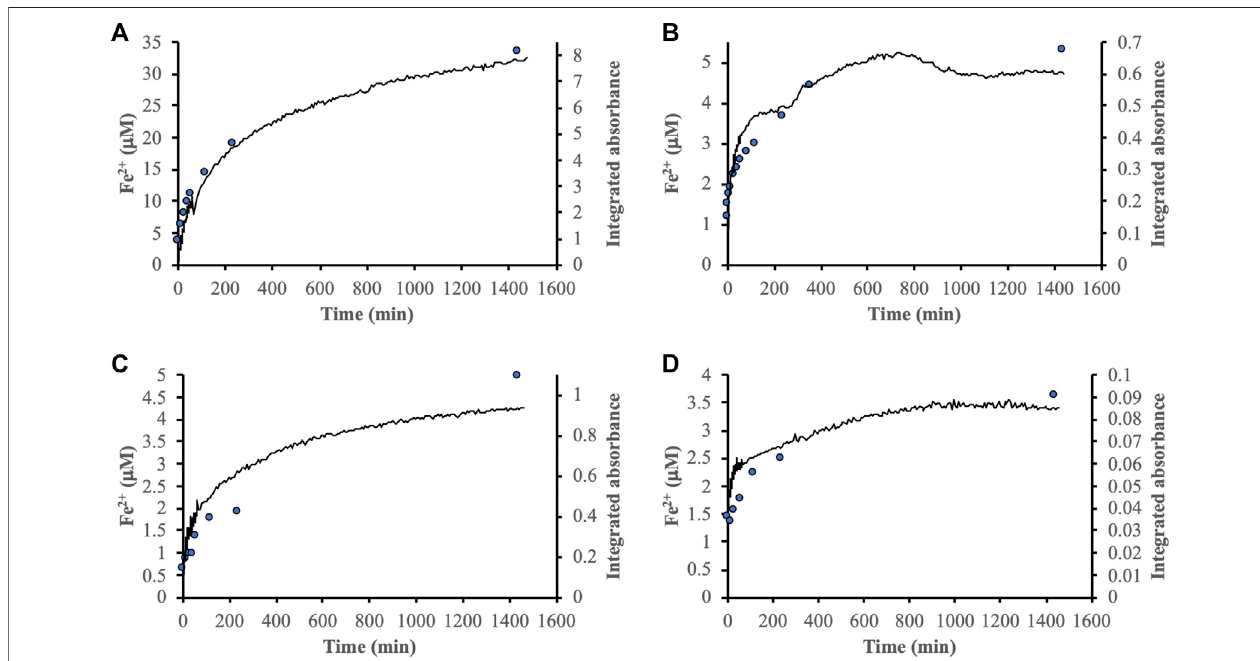
FIGURE 4 | Comparison between [Fe 2+ ] generated by reductive dissolution (blue circles) and adsorption of the modi fi ed DOM fraction determined from the integrated absorbance of IR spectra between ca. 1,850 – 900 cm − 1 (solid black lines). The panels show the reactions between DOM mod-EtOAc and ferrihydrite (A) and goethite (B) , and DOM mod-H2O and ferrihydrite (C) and goethite (D) . All experiments were performed at TOC = 12 μ mol m − 2 .